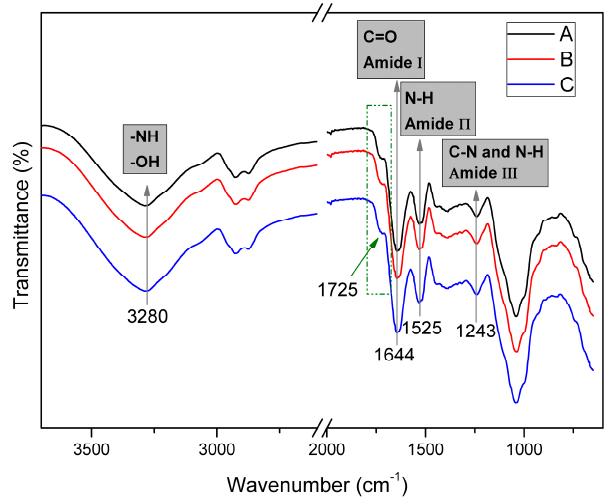
Figure 2. FTIR spectra of soybean meal-based adhesives: (A) MSM adhesive, (B) MSM/NCC adhesive, and (C) MSM/MNCC adhesive.